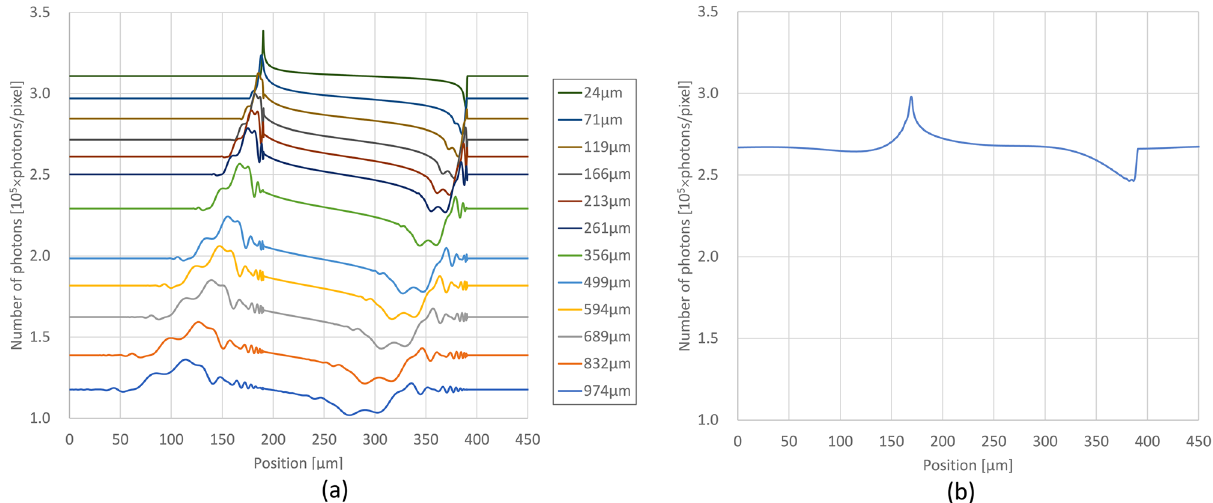
Figure 1. ( a ) Projection profiles for a circular sample with 200 μm diameter at different thicknesses of LAA. ( b ) Projection profile of the same sample taken with BAA. Each graph is plotted at 0.25 μm intervals, with the vertical axis representing the number of photons in the 0.25 μm range. The photon number of incident X-rays is approximately 10 9